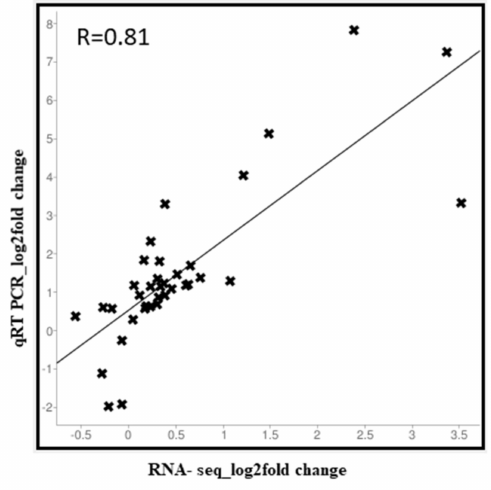
Figure 7. Correlation analysis between RNA-seq and qRT-PCR methods. Log2fold values of RNA-seq data (x-axis) are plotted against log2fold values of qRT-PCR ( y -axis)